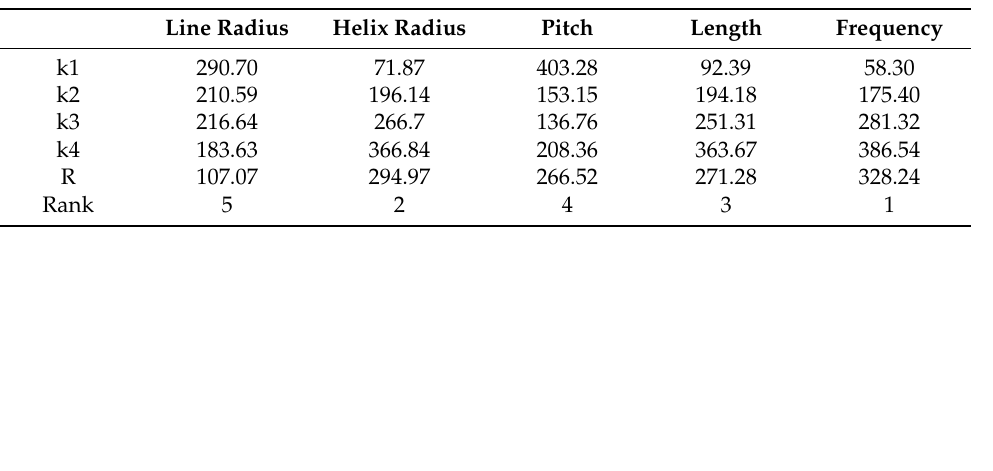
Table 3. The main effect of five parameters acting on the